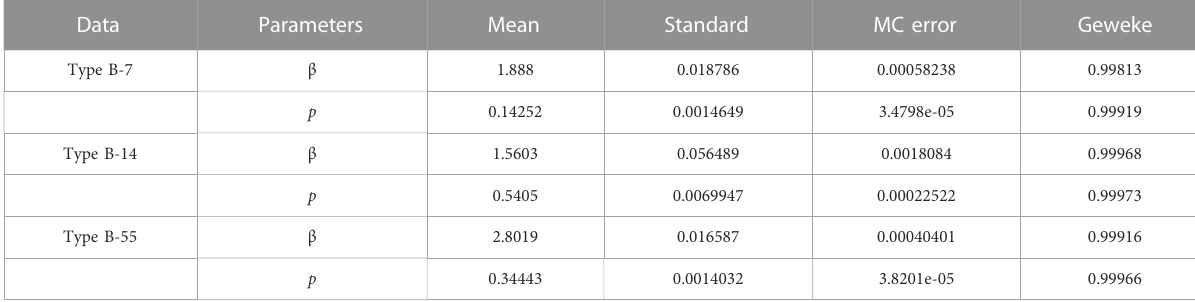
TABLE 2 Parameter estimates obtained using the MCMC method in three types of data.